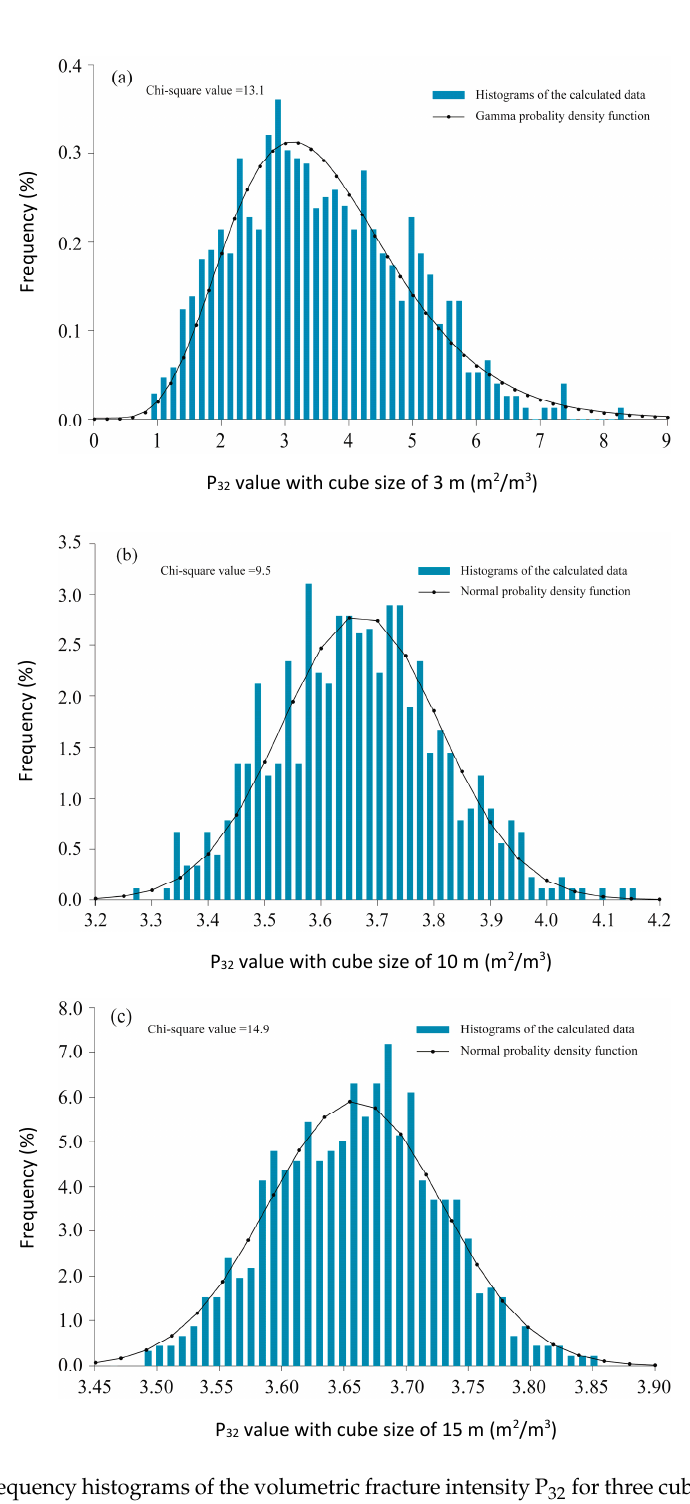
Figure 7. The frequency histograms of the volumetric fracture intensity P 32 for three cube sizes. ( a ) cube size of 3 m. ( b ) cube size of 10 m. ( c ) cube size of 15